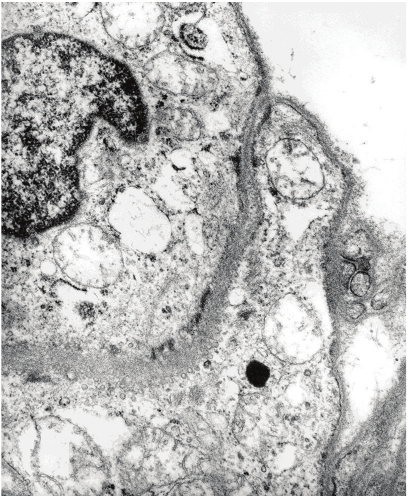
Figure 4: Electron microscopy revealed that the tumor cells contained pinocytotic vesicles and a dense patch lining at the basement